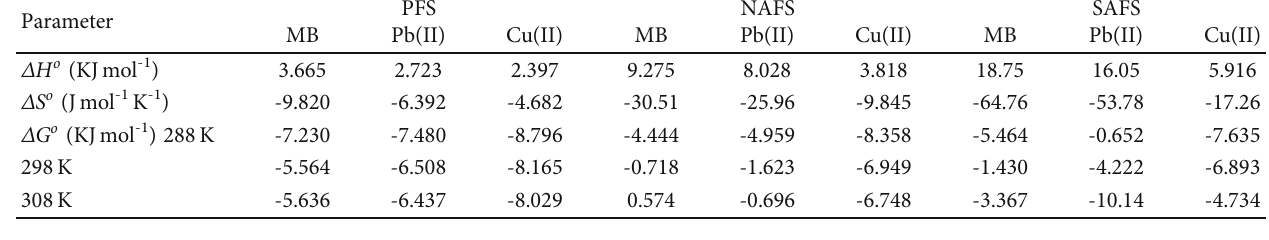
Table 6: Thermodynamics for the adsorption of Pb(II), Cu(II), and MB onto pure (PFS) and treated (NAFS and SAFS) fennel seed adsorbents.